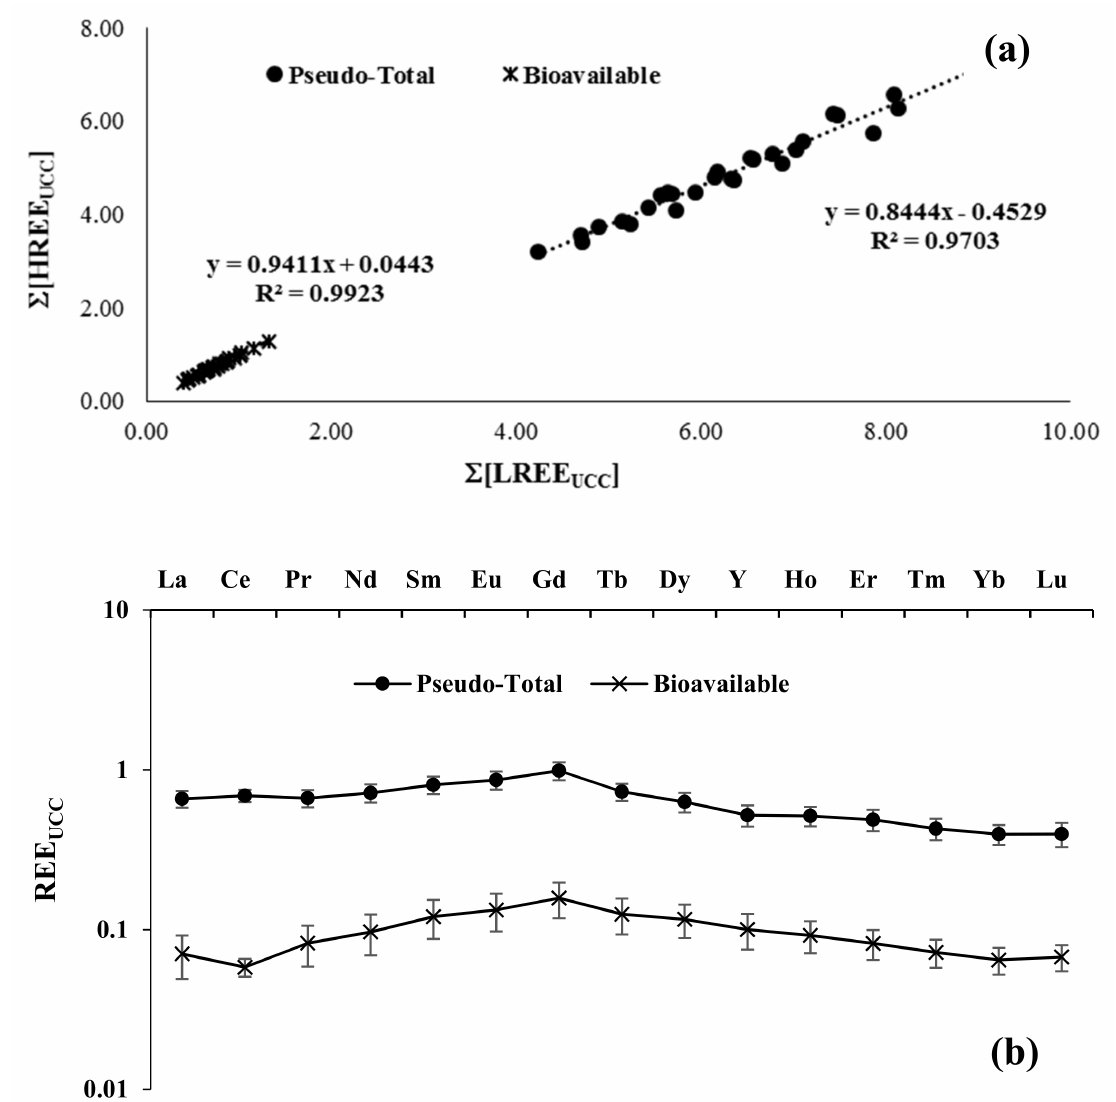
Figure 1. ( a ) ∑ [HREE UCC ] vs. ∑ [LREE UCC ] relation for all Campo Carboj soil samples considering both treatments (pseudo-total and bioavailable). The scales are logarithmic. ( b ) UCC-normalised REE patterns of Campo Carboj soils. Averaged values with standard deviation for both pseudo total and bioavailability